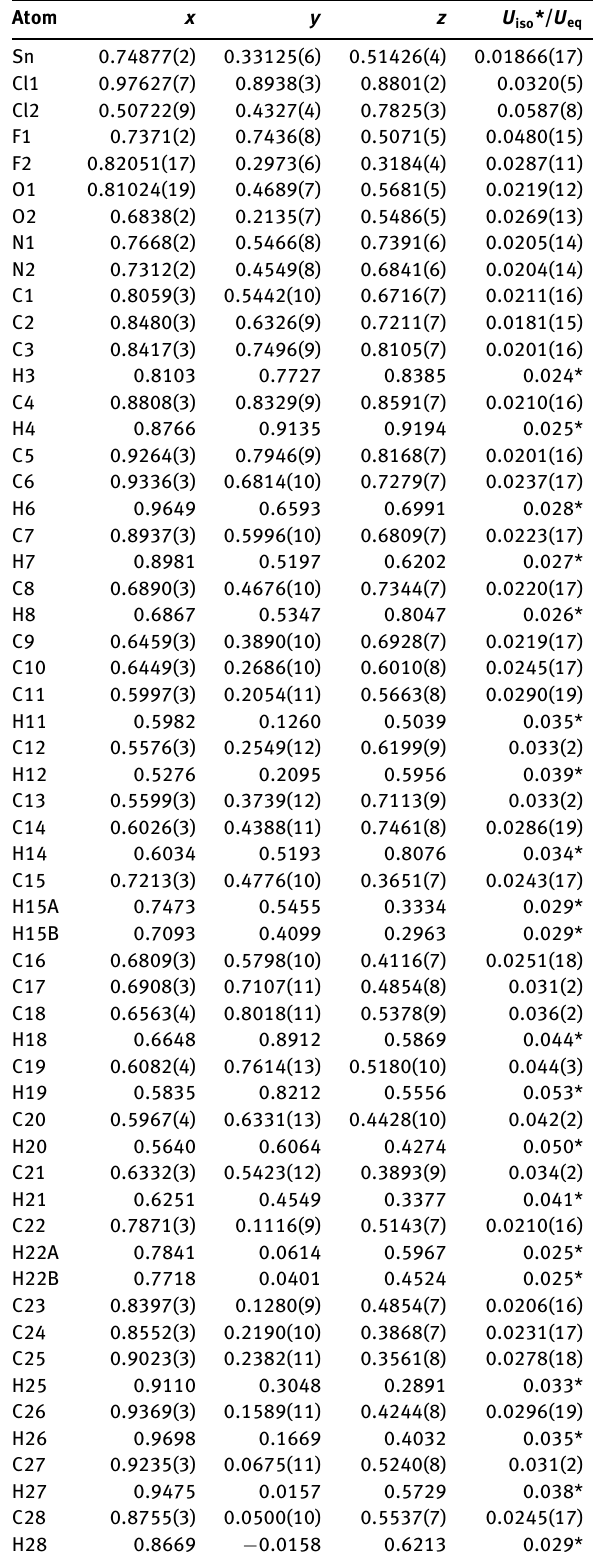
Table 2: Fractional atomic coordinates and isotropic or equivalent isotropic displacement parameters (Å 2